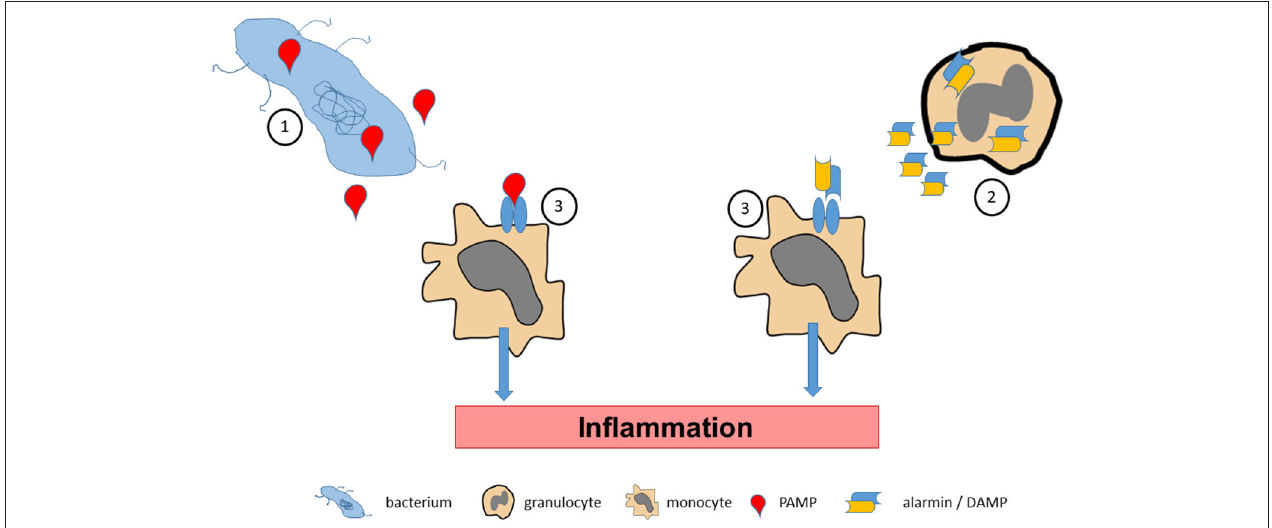
FIGURE 1 | Pathogen associated molecular pattern molecules (PAMPs) are released by bacterial pathogens during infections (1). Accordingly, tissue stress or cellular activation may lead to release of endogenous alarmins or danger associated molecular pattern molecules (DAMPs) under sterile conditions (2). PAMPs and alarmins/DAMPs bind to and activate specific pattern recognition receptors on effector cells (3), which promote inflammatory